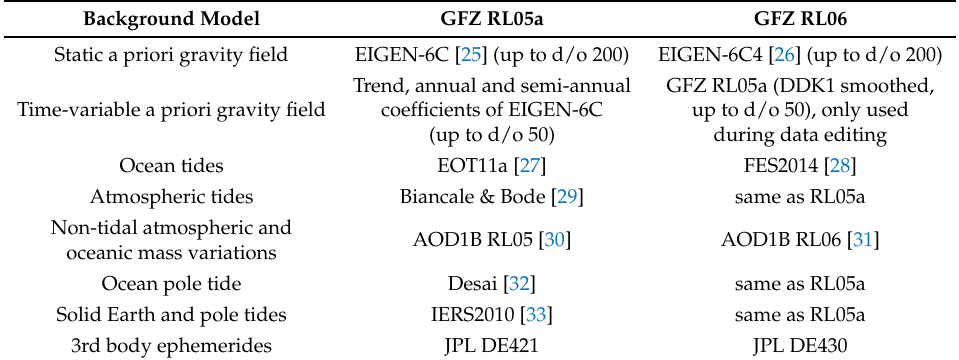
Table 1. Overview of background models used for GFZ RL05a and RL06